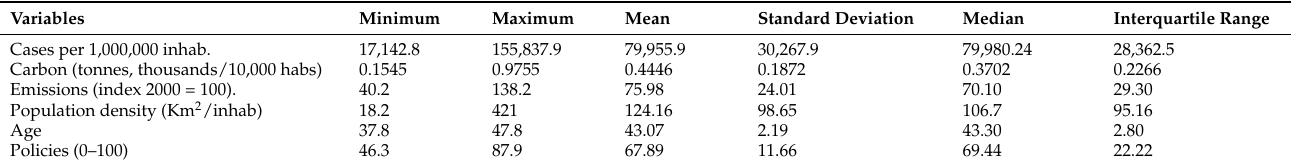
Table 1. Main descriptive measures.